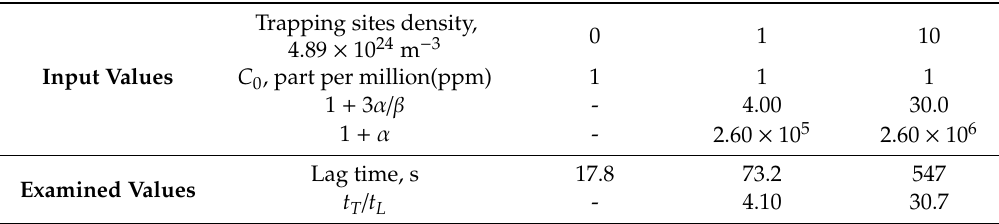
Table 1. Input and examined parameters of simulated permeation curves considering irreversible trapping